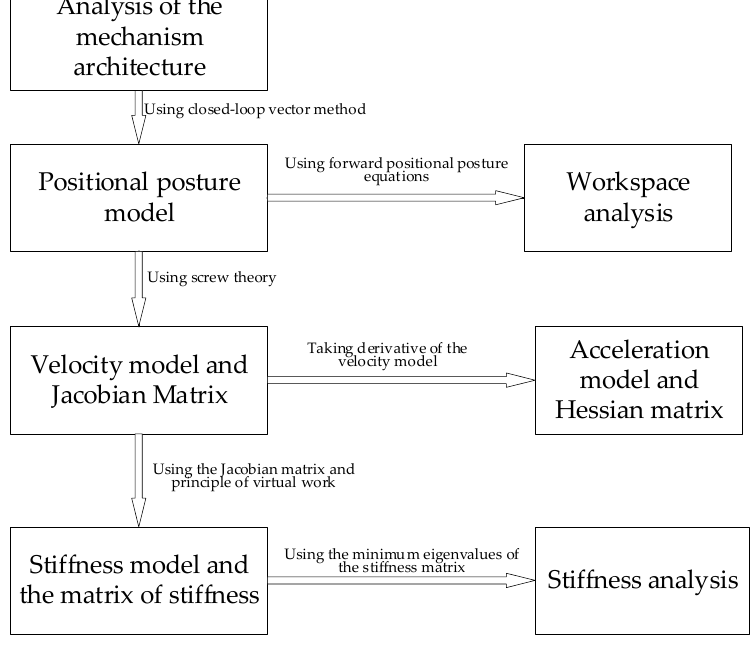
Figure 1. The flowchart of the main content.